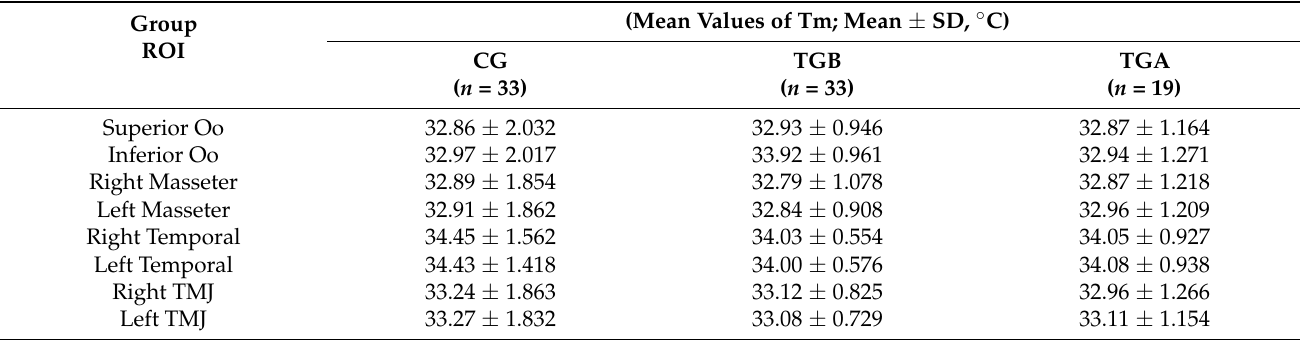
Table 1. Mean values of the average temperature (Tm) recorded in the thermograms of the studied ROI for the CG, TGB and TGA groups.